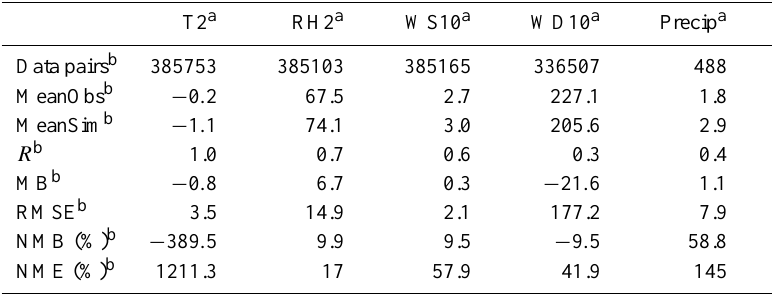
Table 6. Performance statistics of WRF simulation.